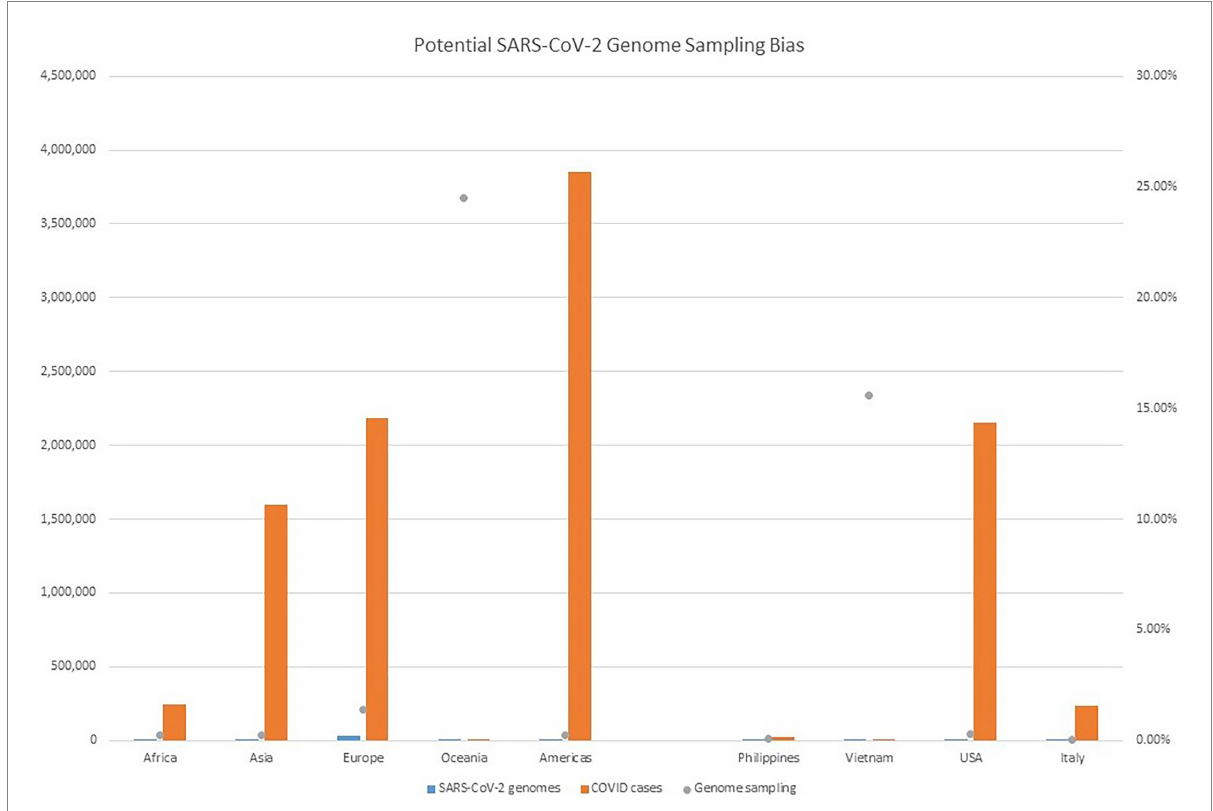
FIGURE 4 Potential SARS-CoV-2 Genome Sampling Bias. The number of cases per geographic region at the time of the outbreak aboard CVN-71 is represented by red bars and the left y axis, the number of viral genomes in GISAID for each geographic region at the time is depicted by blue bars and the left y axis, and is depicted by blue bars and the left y axis, and the proportion of viral genomes sampled per geographic region is denoted with a gray dot. Number of cases by continent was taken from